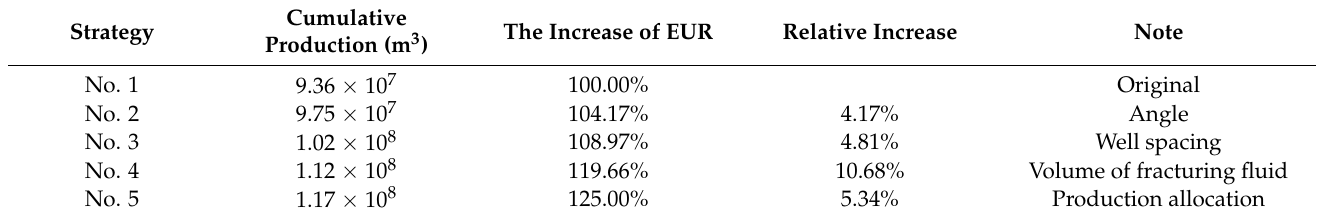
Figure 15. The cumulative production curves under different strategies. Table 4. The increase in EUR under different